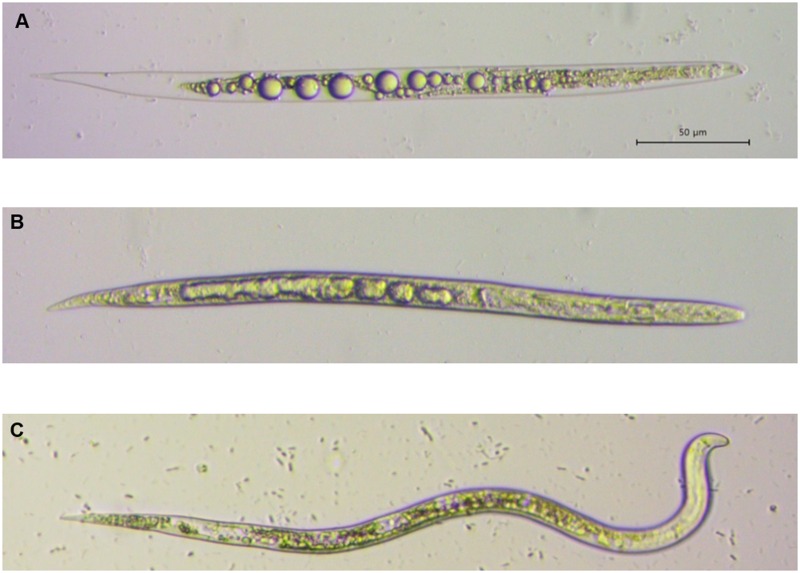
Morphological variations in M. incognita J2s treated with 2 mmol/L oxalic acid (A), 2 mmol/L cinnamaldehyde (B), and water (C).Bar = 50 μm.